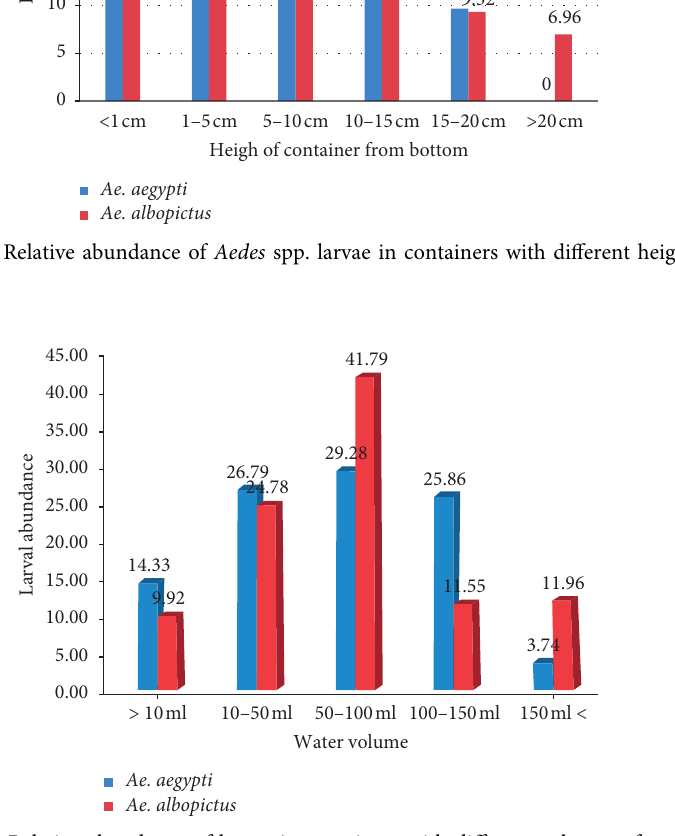
Figure 7: Relative abundance of larvae in containers with different volumes of